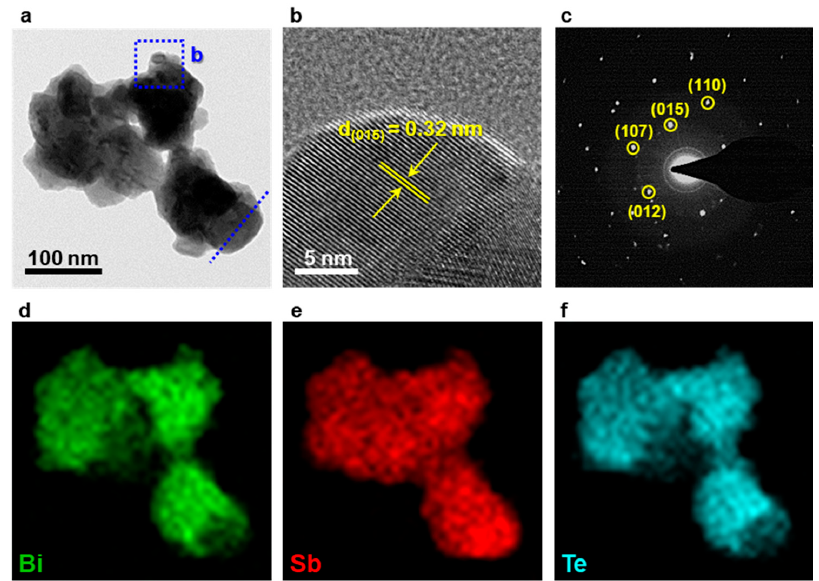
Figure 4. ( a , b ) High-resolution (HR)-transmission electron microscopy (TEM) images, ( c ) selected- area electron diffraction (SAED) pattern, ( d – f ) elemental mapping images from STEM-EDS. Table 1. Compositions of as-synthesized BST NPs estimated by EDS.